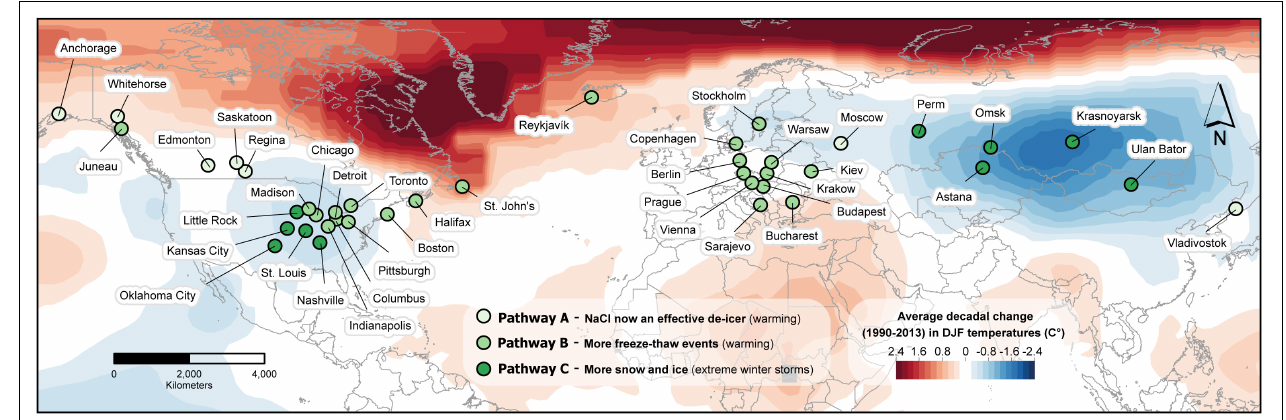
FIGURE 1 | Three pathways by which future climate warming may, counterintuitively, result in cities increasing their use of winter de-icing salt: (A) Warming winter temperatures in cities that were historically too cold to make effective use of sodium chloride for de-icing; (B) cities where winter daily high temperatures may increase the frequency of freeze-thaw cycles; and, (C) cities in North America and Eurasia that may experience more severe winter storms resulting from greater variability in the circumpolar vortex. Cities are selected to be representative locations for each scenario and do not constitute an exhaustive list. Locations experiencing Pathway B may also be subject to Pathway C. Temperature surface adapted from Cohen et al.